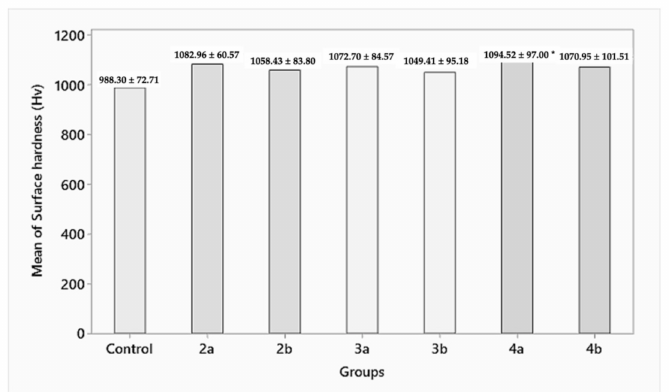
Figure 5. Surface hardness of the abraded zirconia samples (HV). * Statistically significant difference between the